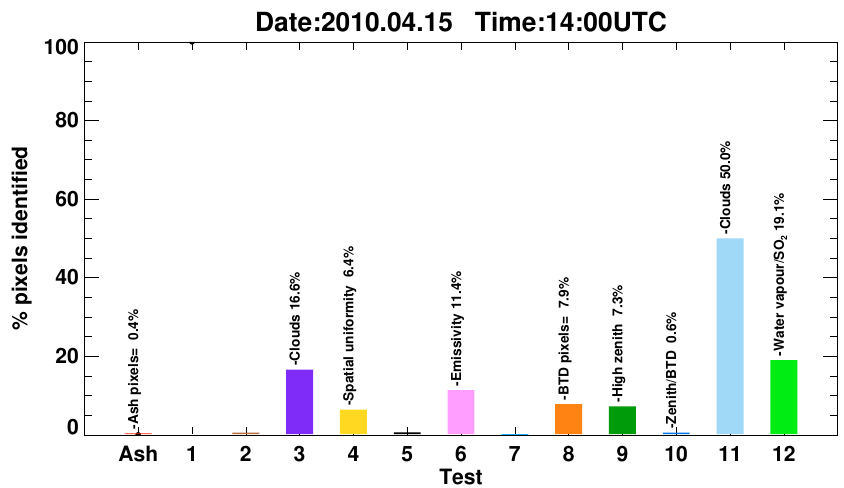
Figure 18. Histogram of CID pixels identified by each of the tests. The percentages represent pixels identified by the test out of the total image pixels (759278). The sum of the percentages exceeds 100% because different tests are satisfied by the same